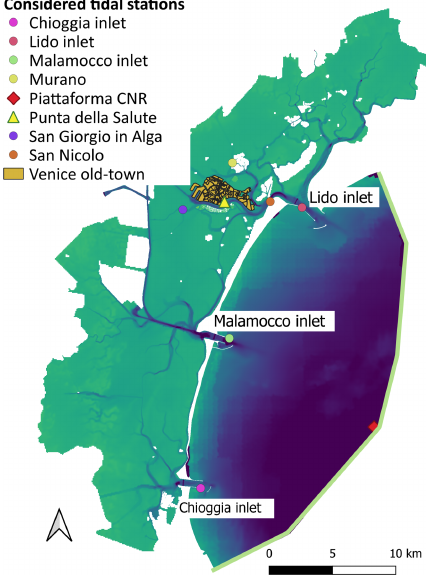
Figure 2. Study area consisting of part of the Adriatic shelf, the Venetian Lagoon and the old town of Venice. Green line indicates the applied boundary condition for the water level time